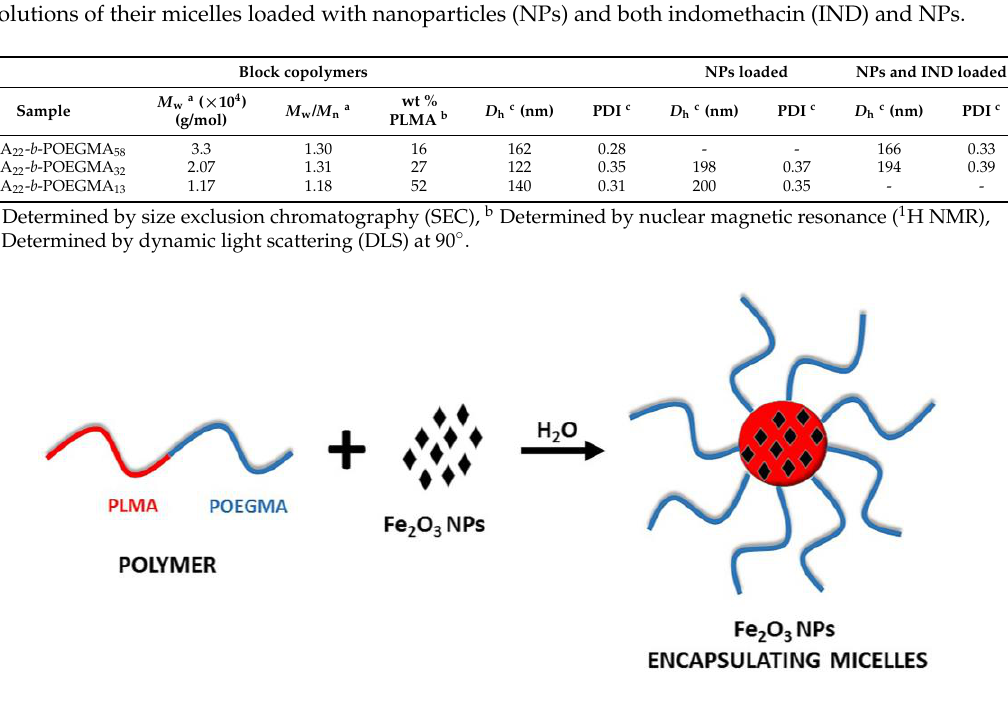
Scheme 1. Simplified schematic illustration depicting the preparation of the PLMA- b -POEGMA/NPs mixed